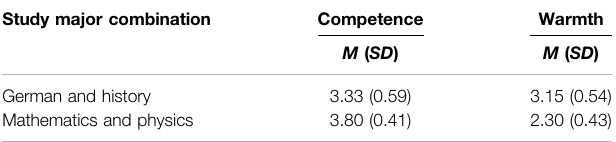
TABLE 3 | Competence and warmth ratings of pre-service teachers with different study major combinations in Study 3a (open-ended questions). Study major